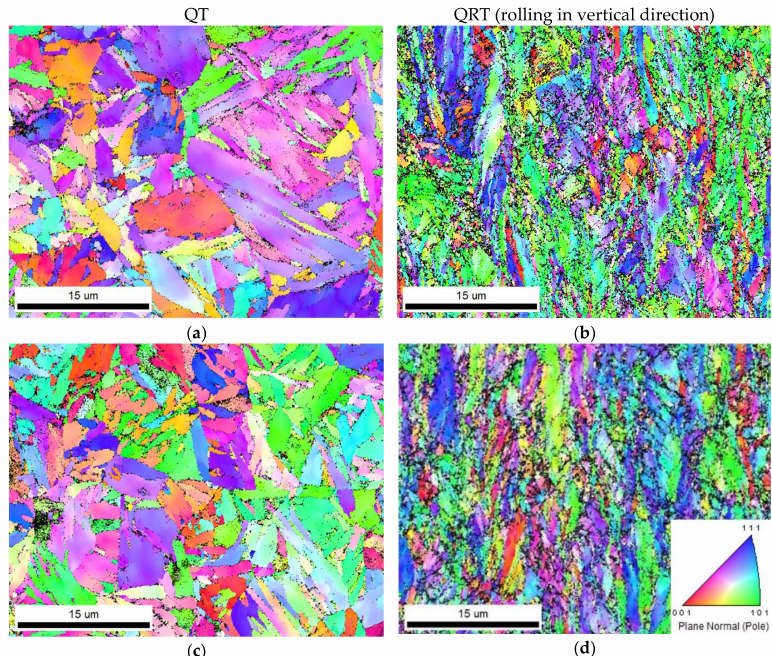
Figure 10. Inverse pole figure (IPF) maps for 0Cu and 1.5Cu materials tempered for 60 min at temperature 500 ◦ C: ( a ) 0Cu QT; ( b ) 0Cu QRT; ( c ) 1.5Cu QT; ( d ) 1.5Cu QRT. The map step was 0.05 µ m. The coloring indicates local lattice orientation (legend in ( d )). The rolling direction is oriented vertically for the QRT samples.